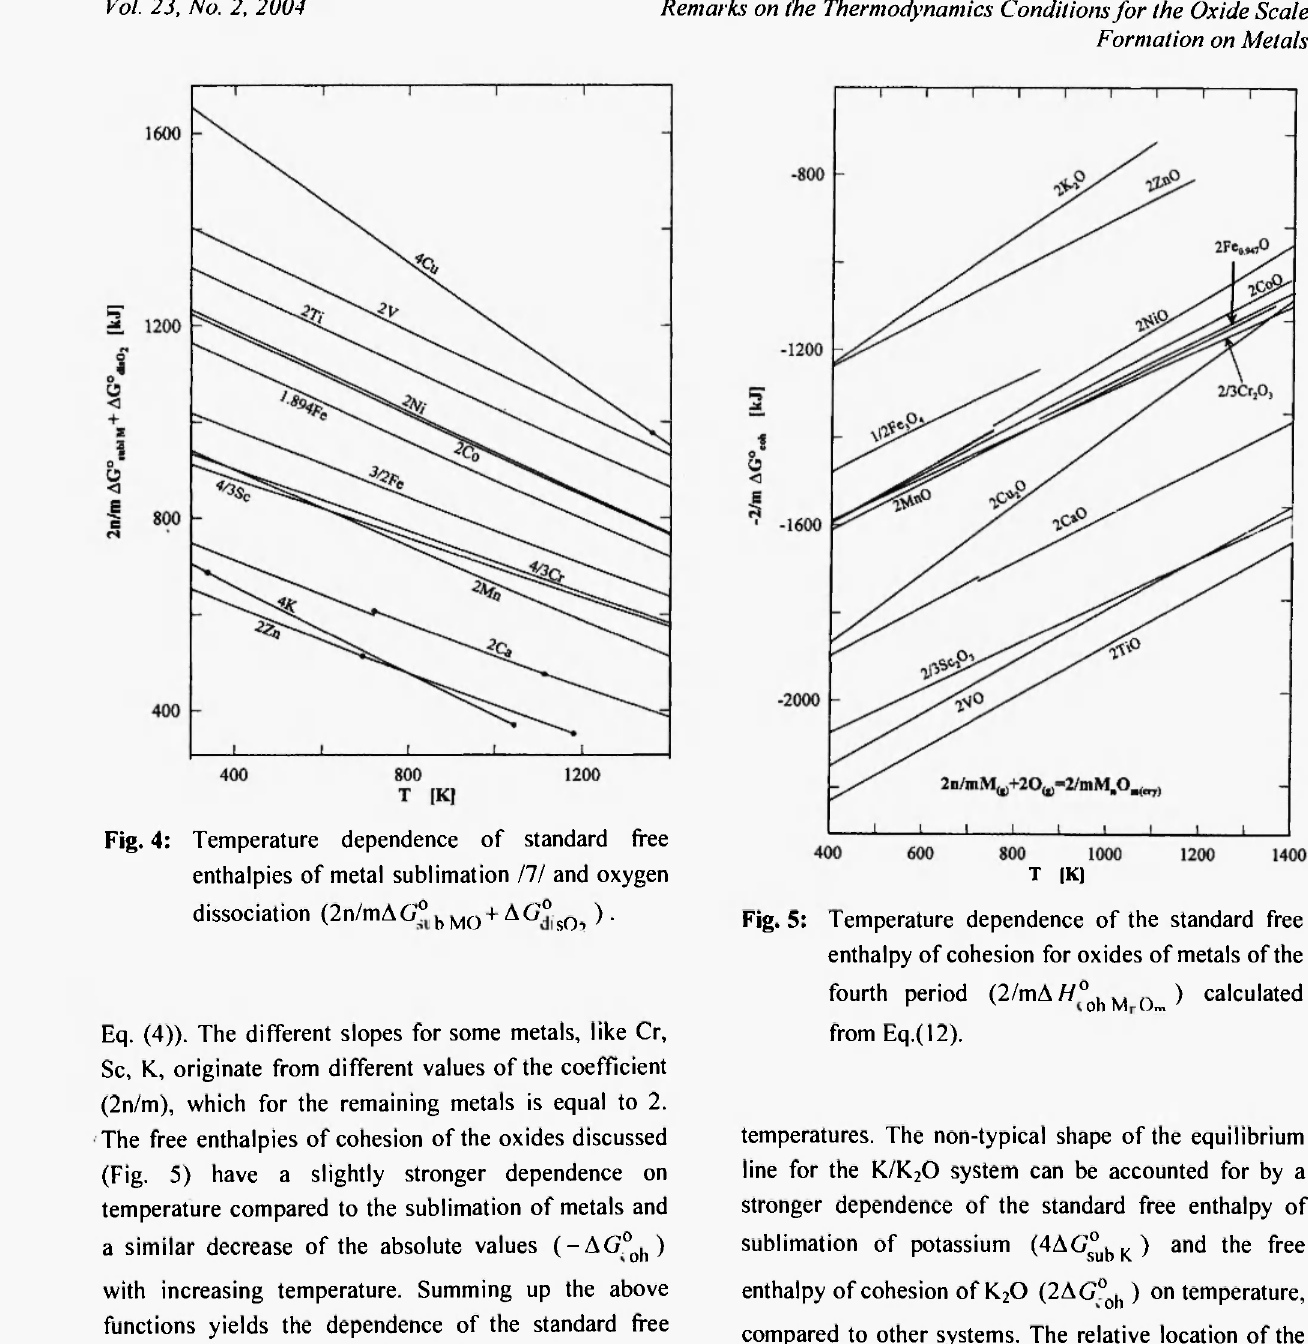
τ [Κ] Fig. 5: Temperature dependence of the standard free enthalpy of cohesion for oxides of metals of the fourth period ( 2 / m A W ° o h MO ) calculated from